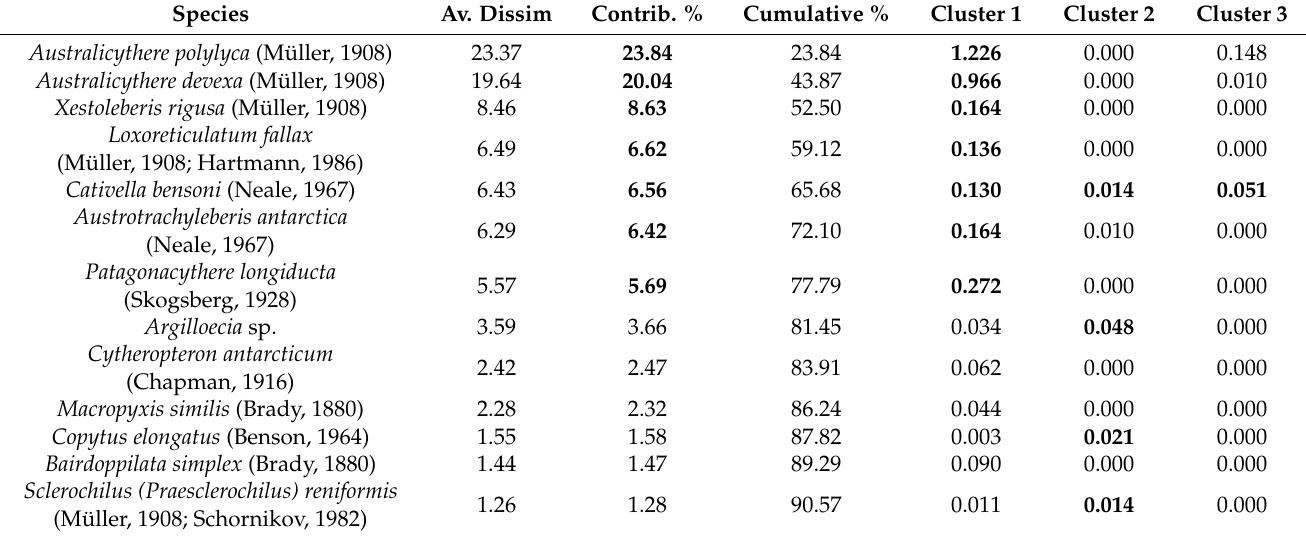
Table 2. Similarity percentage (SIMPER) analysis for ostracod assemblages defined with Q-mode. Cluster analysis: The dominant species for each cluster are reported in bold. Overall average dissimilarity: